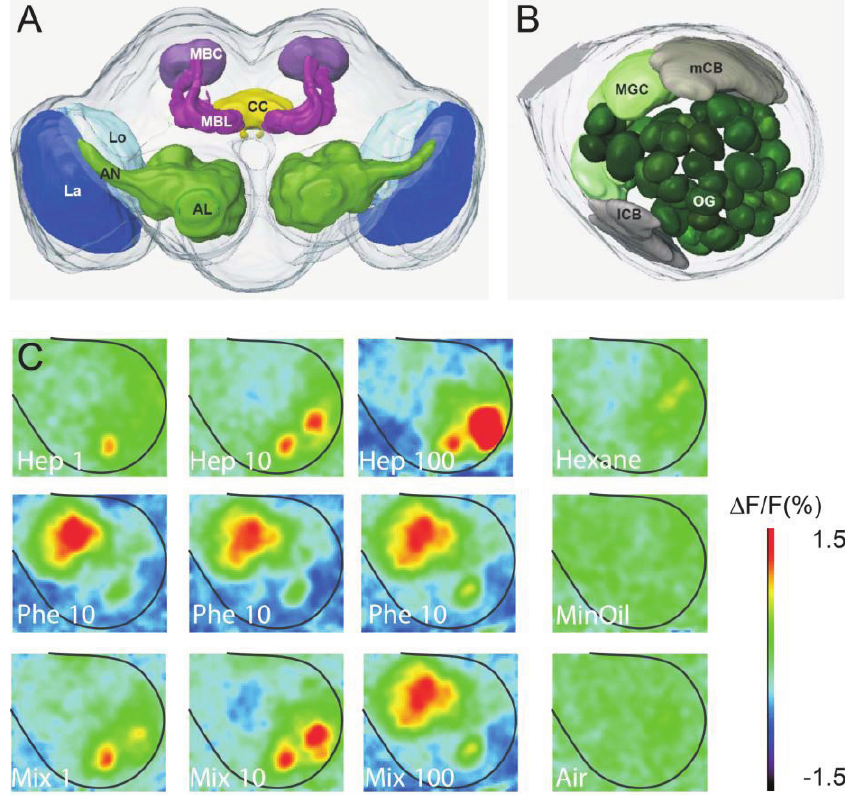
Figure 3. The Agrotis ipsilon brain and pheromone-plant odor interactions visualized in the antennal lobe by in vivo calcium imaging. ( A ) Schematic representation of the noctuid moth brain and ( B ) the antennal lobe. ( C ) False color-coded images of optically recorded antennal lobe activity. In response to different doses of heptanal (Hep 1, 10 and 100 μg), the behaviorally active sex pheromone blend (Phe) at 10 ng and the heptanal-pheromone blend mixture (Mix, containing 10 ng of pheromone blend and 1, 10 or 100 μg of heptanal). Hexane, the solvent of the pheromone, mineral oil (MinOil), the solvent of heptanal, as well as air, are control stimulations. All maps are scaled to the same minimum/maximum as indicated by the color scale and originate from a single five days-old male moth. AL antennal lobe, AN antennal nerve, CC central complex, La lamina, lCB lateral cell body cluster, Lo lobula, MBC mushroom body calyces, MBL mushroom body lobes, mCB medial cell body cluster, MGC macroglomerular complex, OG ordinary